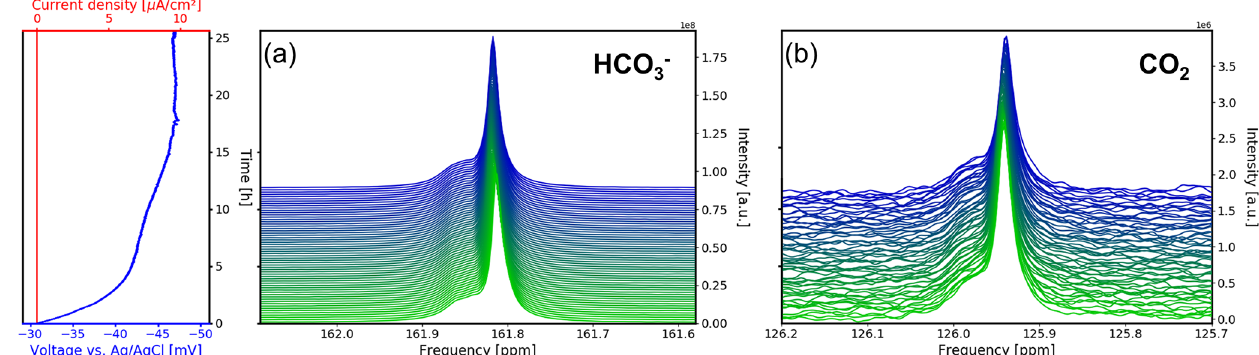
− (a) and CO 2 (b) during the OCV stage vs. electrochemical potential between the Figure 8. Time evolution of the 13 C signals for HCO 3 working and reference electrodes and current density between the working and counter electrodes. In each subpanel the time-dependent potential and current density are shown on the left, with the corresponding spectra given on the right. After a relaxation period the potential remains at a stable at 47mV.